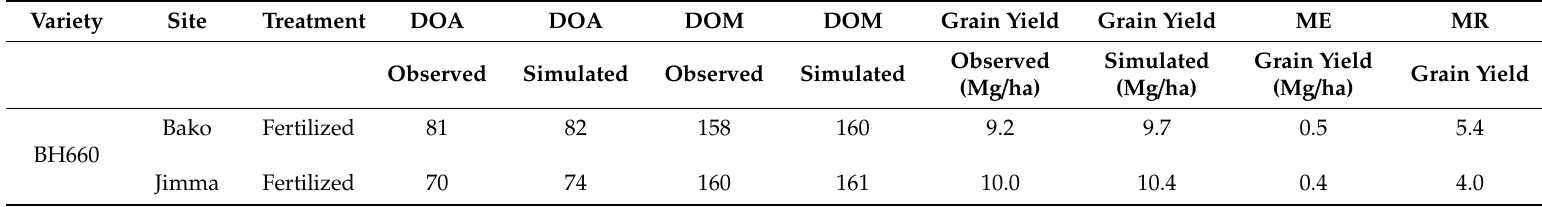
Table 4. Observed and simulated values of grain yield, Day of Anthesis (DOA), Day of Maturity (DOM), mean residual error (ME), and mean absolute error (MR), for the maize variety BH660 in the two sites Bako and Jimma